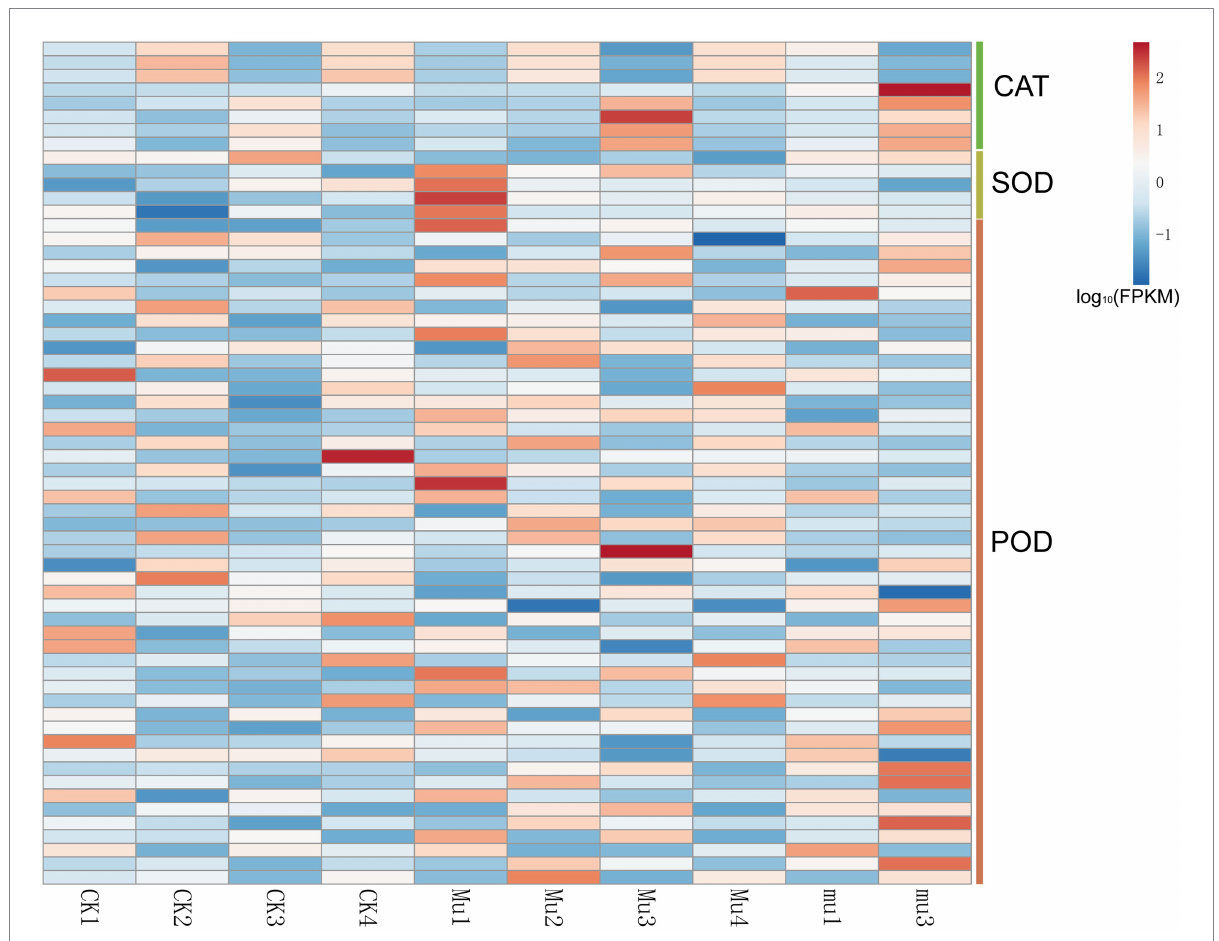
FIGURE 5 Heatmap showing the expression of DEGs related to enzymic antioxidant. Gene expression is normalized using FPKM and represents the means of three biological replicates. Expression values are presented as FPKM normalized log10-transformed counts. The color represents relative gene expression levels. While the horizontal direction shows the sample names, the vertical direction shows the names of genes involved in osmotic regulation. DEGs involved direct to those encoding catalase, superoxide dismutase, peroxidase, and glutathione